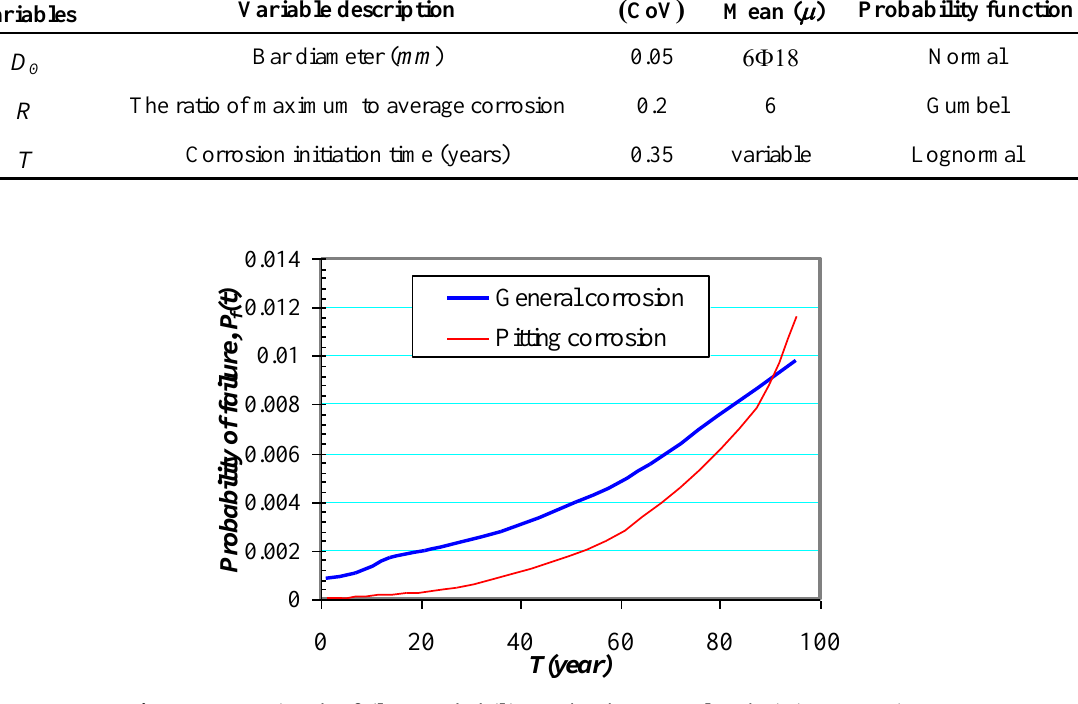
Fig. 3. Comparing the failure probability under the general and pitting corrosion